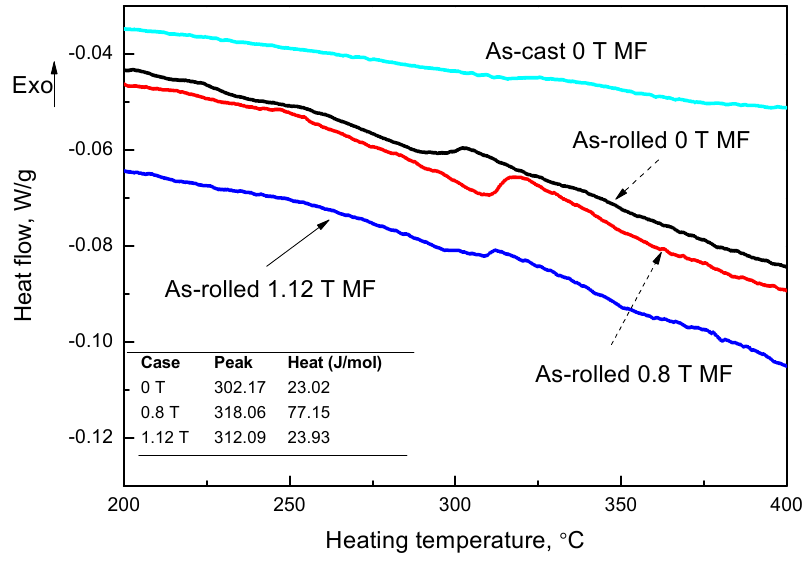
Figure 5. DSC curves of as-rolled Ag-Cu alloys at a heating rate of 10 K/min.